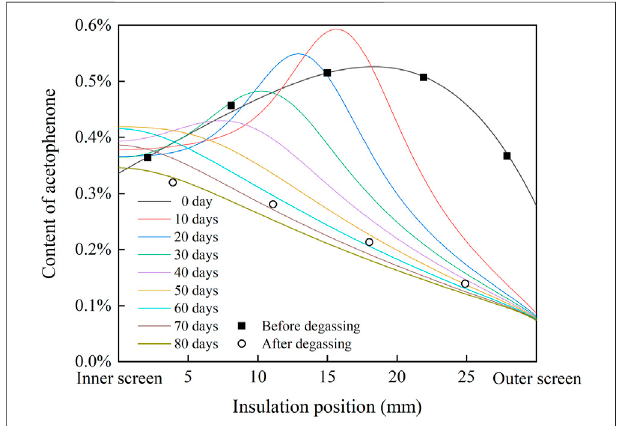
FIGURE 6 | Radial distribution of acetophenone in cable insulation modeling by the phase fi eld in the double well model.